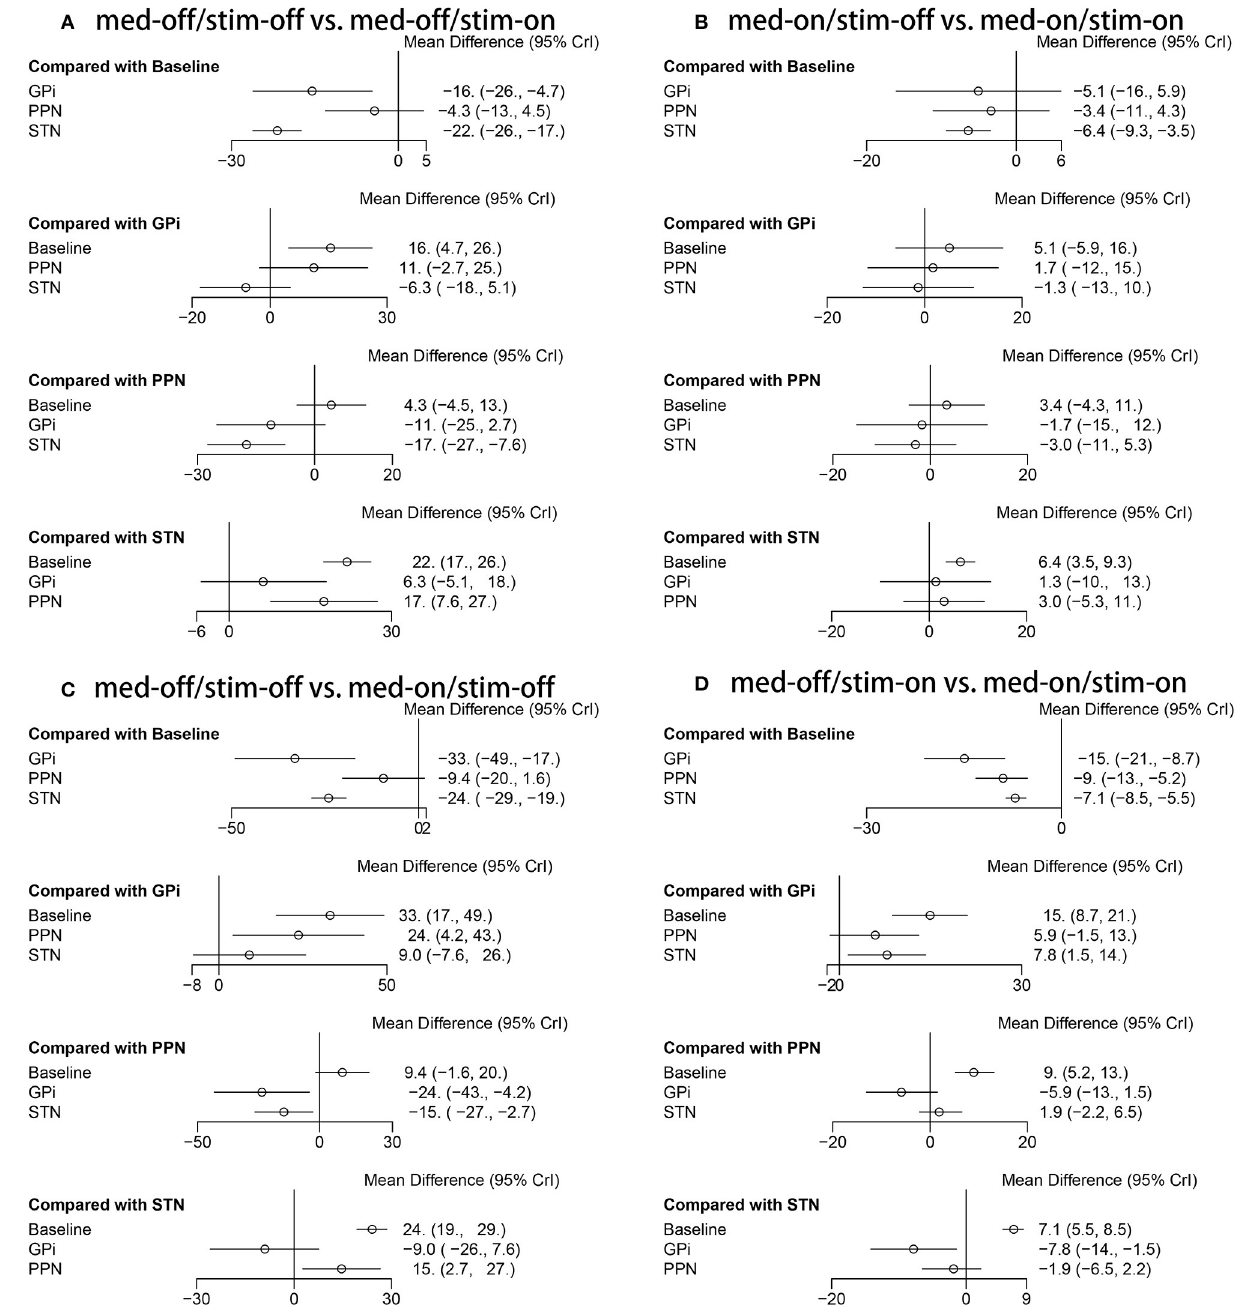
FIGURE 7 | Forest plot of mean difference of UPDRS-III (Total); (A) med-off/stim-off vs. med-off/stim-on, (B) med-on/stim-on vs. med-on/stim-on, (C) med-off/stim-off vs. med-on/stim-off, (D) med-off/stim-on vs.